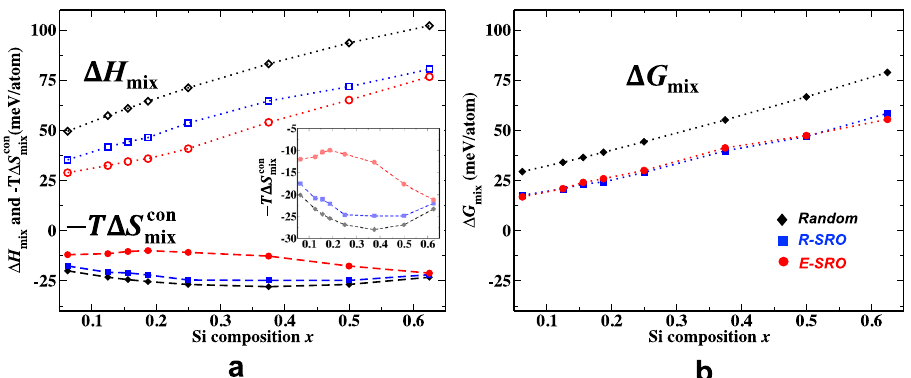
Fig. 3 Thermodynamic analysis of Si x Ge 0.75 − x Sn 0.25 alloy at room temperature. a Variation of the calculated enthalpy of mixing Δ H mix (open symbols on the top) and the free energy contribution from the con fi guration entropy of mixing (cid:2) T Δ S con (shaded symbols at the bottom) with Si composition x for a mix at a different scale to show its variation with Si composition. b Variation of the calculated random (black), R-SRO (blue) and E-RSO (red). Inset is (cid:2) T Δ S con mix total free energy of mixing Δ G mix ¼ Δ H mix (cid:2) T Δ S con with x . R-SRO and E-SRO are nearly degenerate in their Δ G mix